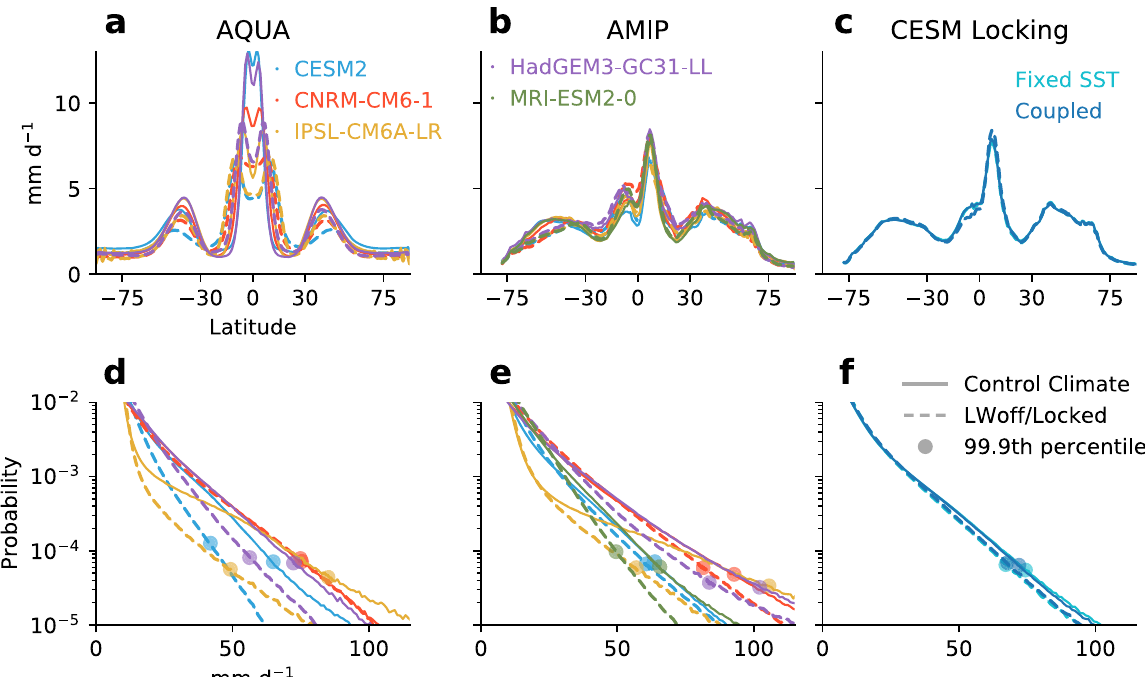
Fig. 1 Simulated precipitation distributions. a – c Zonal average precipitation and d – f histogram of tropical marine precipitation for (left-to- right) aquaplanet experiments, AMIP experiments, and CESM2 cloud-locking experiments. Colors are as noted in legends, with solid curves showing the control simulations and dashed curves showing the LWoff or cloud-locked